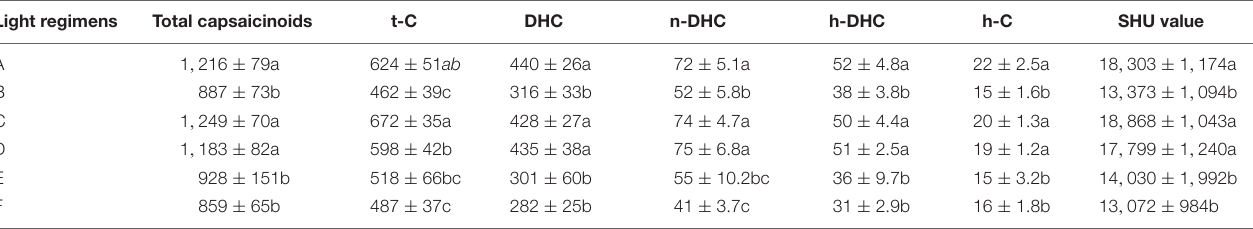
TABLE 3 | The amount of capsaicinoids (mg/kg DW) and the pungency level Scoville Heat Unit (SHU) value of chilli fruits: trans-capsaicin (t-C), dihydrocapsaicin (DHC), nordihydrocapsaicin (n-DHC), homocapsaicin (h-C); homodihydrocapsaicin (h-DHC), and the values of SHU. Light regimens Total